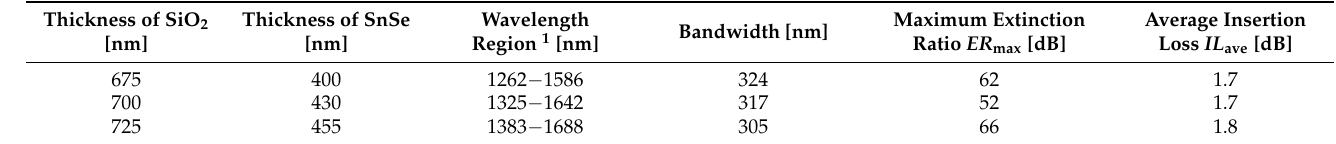
Figure A3. The contour maps of extinction ratio spectrum varied with the thickness of SnSe for the SiO 2 ’s thickness of ( a ) 675, ( d ) 700, and ( g ) 725 nm, and the two representative thicknesses of SnSe layer ( d SnSe = ( b ) 400 and ( c ) 315 nm for SiO 2 ’s thickness of 675 nm, ( e ) 430 and ( f ) 290 nm for that of 700 nm, and ( h ) 455 and ( i ) 280 nm for that of 725 nm) corresponding to the maximum value of extinction ratio ER max . Table A1. Performances of separating p light over broadband with thicker SnSe’s thickness ( d SnSe = 400, 430 and 455 nm) respectively at the SiO 2 ’s thickness of 675, 700, and 725